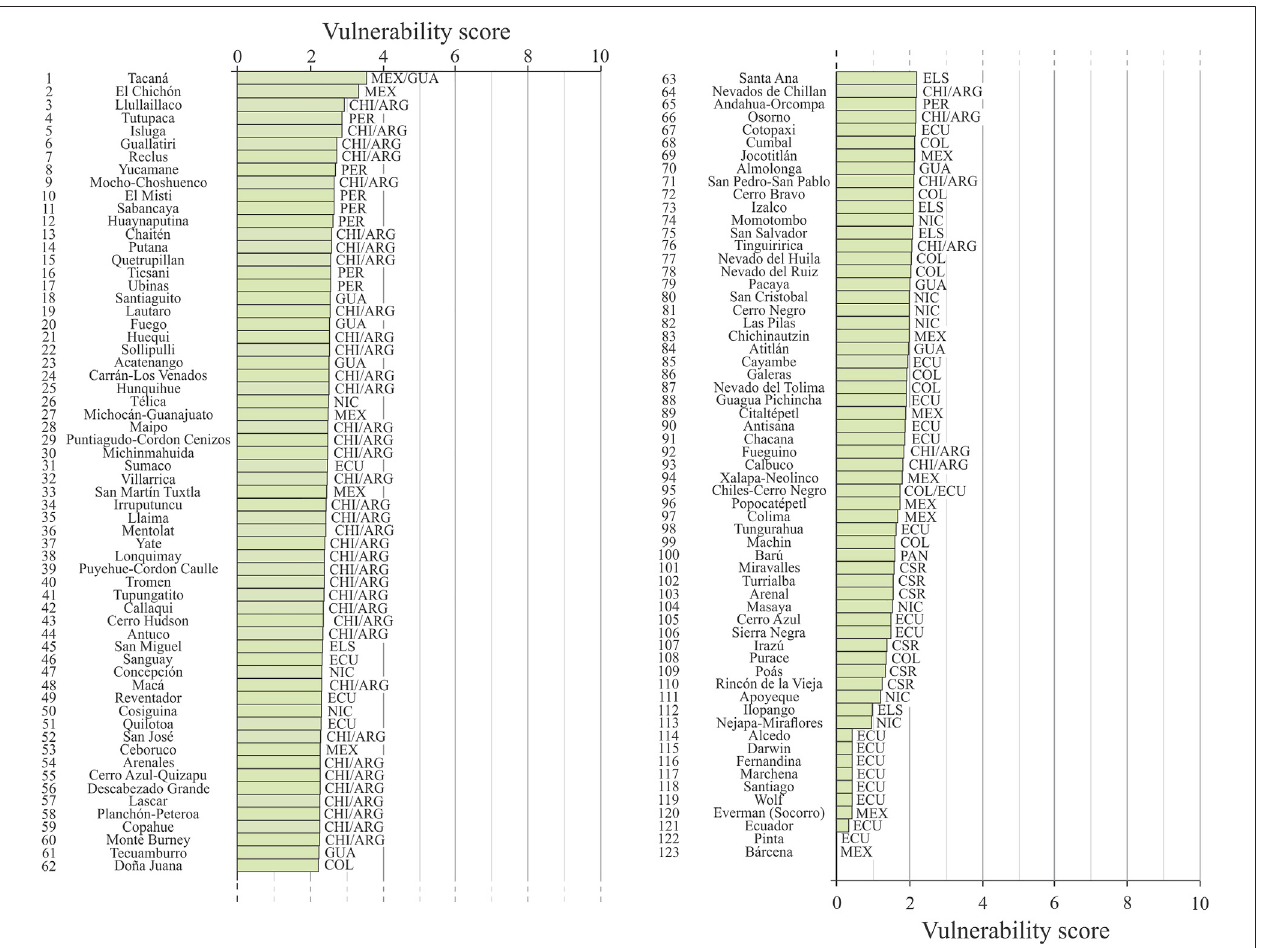
FIGURE 6 | Latin America volcanic systems with recorded activity in the past 1,000 years assessed based on their vulnerability score. CHI/ARG: Chile/Argentina; COL: Colombia; CSR: Costa Rica; ECU: Ecuador; ELS: El Salvador; GUA: Guatemala; MEX: México; NIC: Nicaragua; PER: Peru.